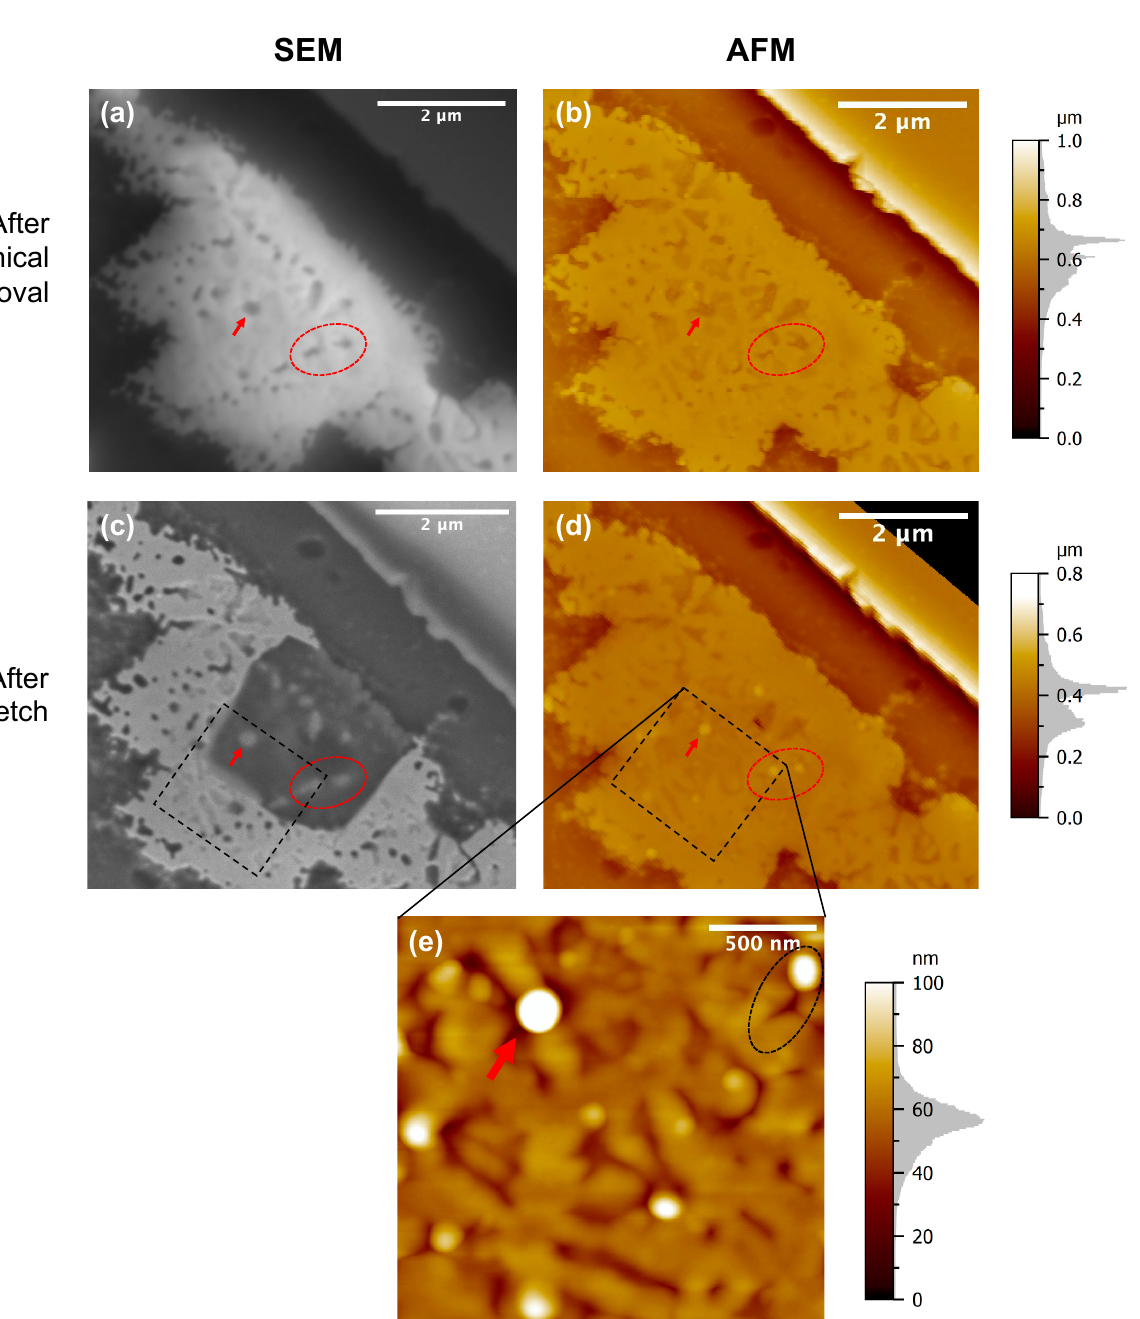
Figure 7. ( a ) Plan-view SEM micrograph of the solidified Au-Si-Ge eutectic from a large-opening micro-crucible after its capping layer was mechanically removed. ( b ) AFM micrograph of the same region. ( c ) Plan-view SEM micrograph of the same region after the sample was dipped into a Transene Gold Etchant TFA solution for 55 s. ( d ) AFM micrograph of the same region. ( e ) A higher resolution AFM micrograph of the region inside the dashed black box in ( c ) and ( d ). The red arrow and the dashed red oval in all figures correspond to the same region of nano-rods.